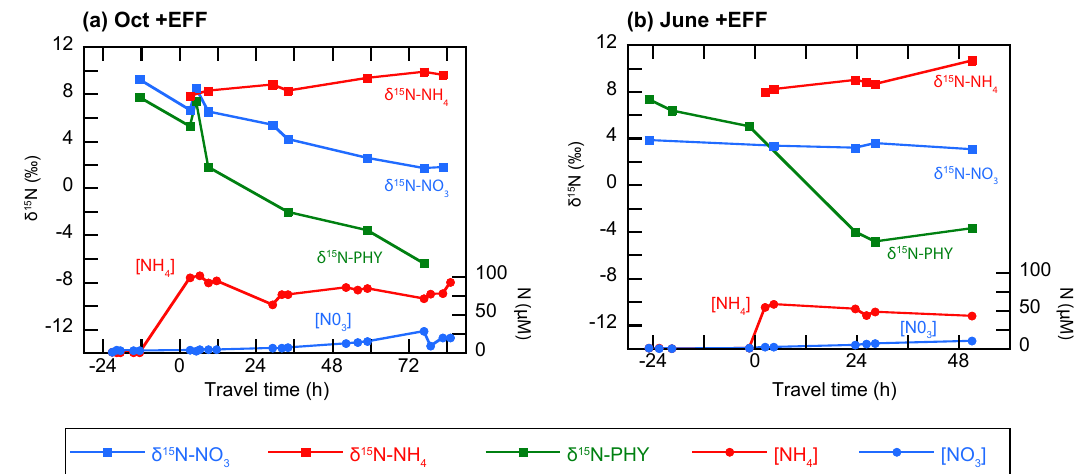
Figure 5. δ 15 N-NO 3 , δ 15 N-NH 4 , and δ 15 N-PHY in parcels that received effluent from the WWTP ( + EFF) in October (a) and June (b) . Samples are plotted by travel time, where zero indicates the time the parcel passed the location where effluent high in NH + The concentration of NH + was too low to allow for isotopic analysis upstream of the WWTP. 4